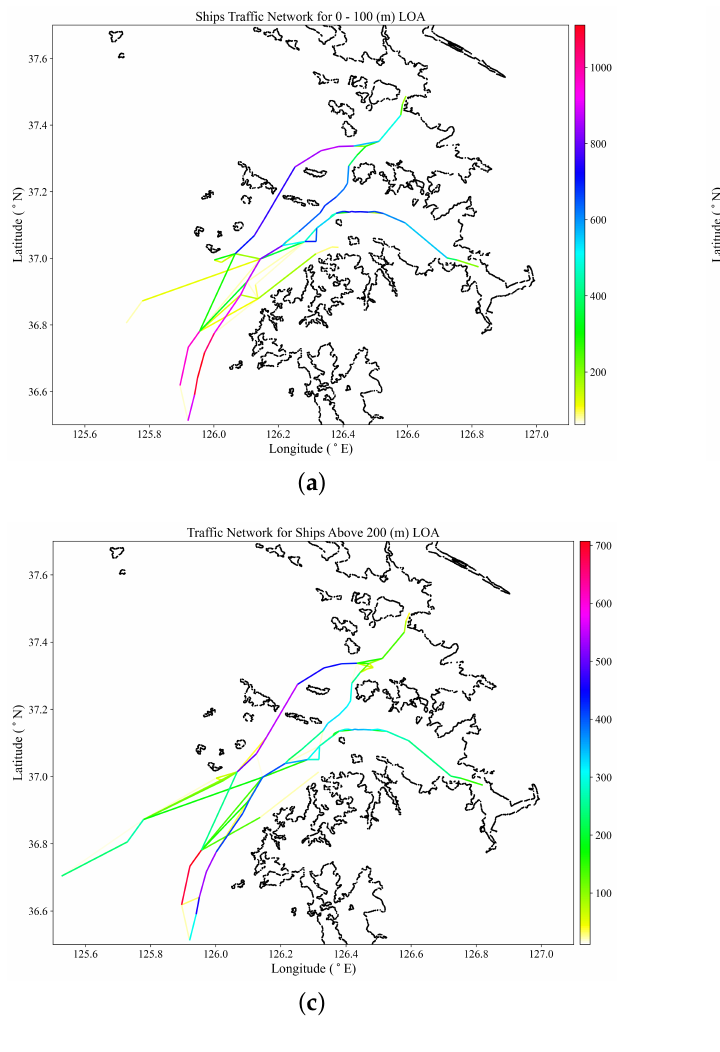
Figure 9. Maritime Traffic Network by ship length overall (LOA). ( a ) 0–100 m LOA. ( b ) 100–200 m LOA. ( c ) Over 200 m